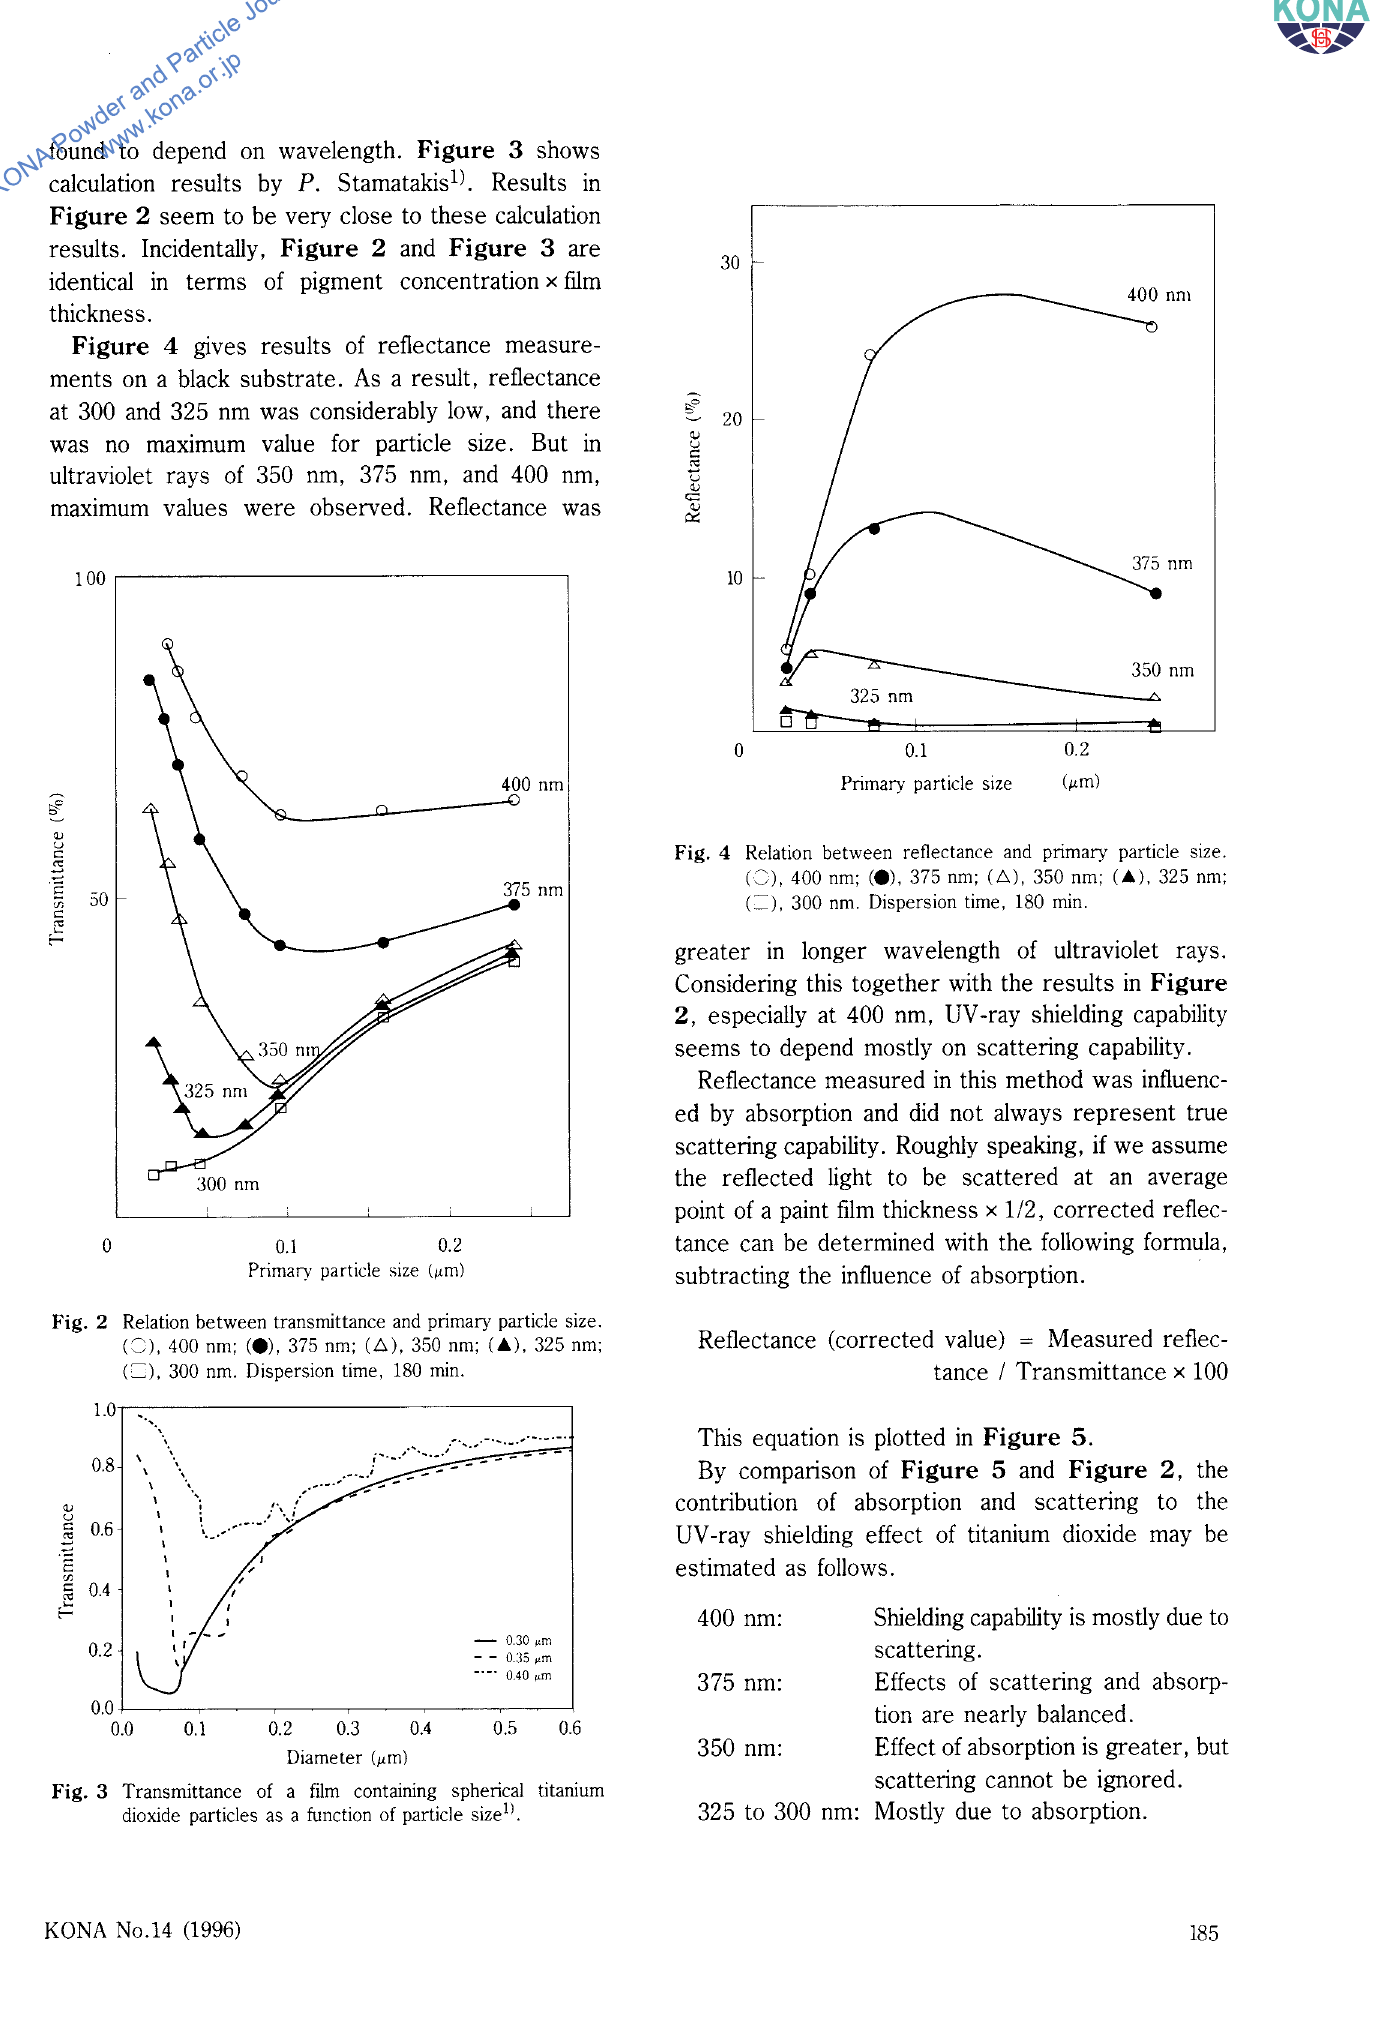
KONA No.l4 (1996)